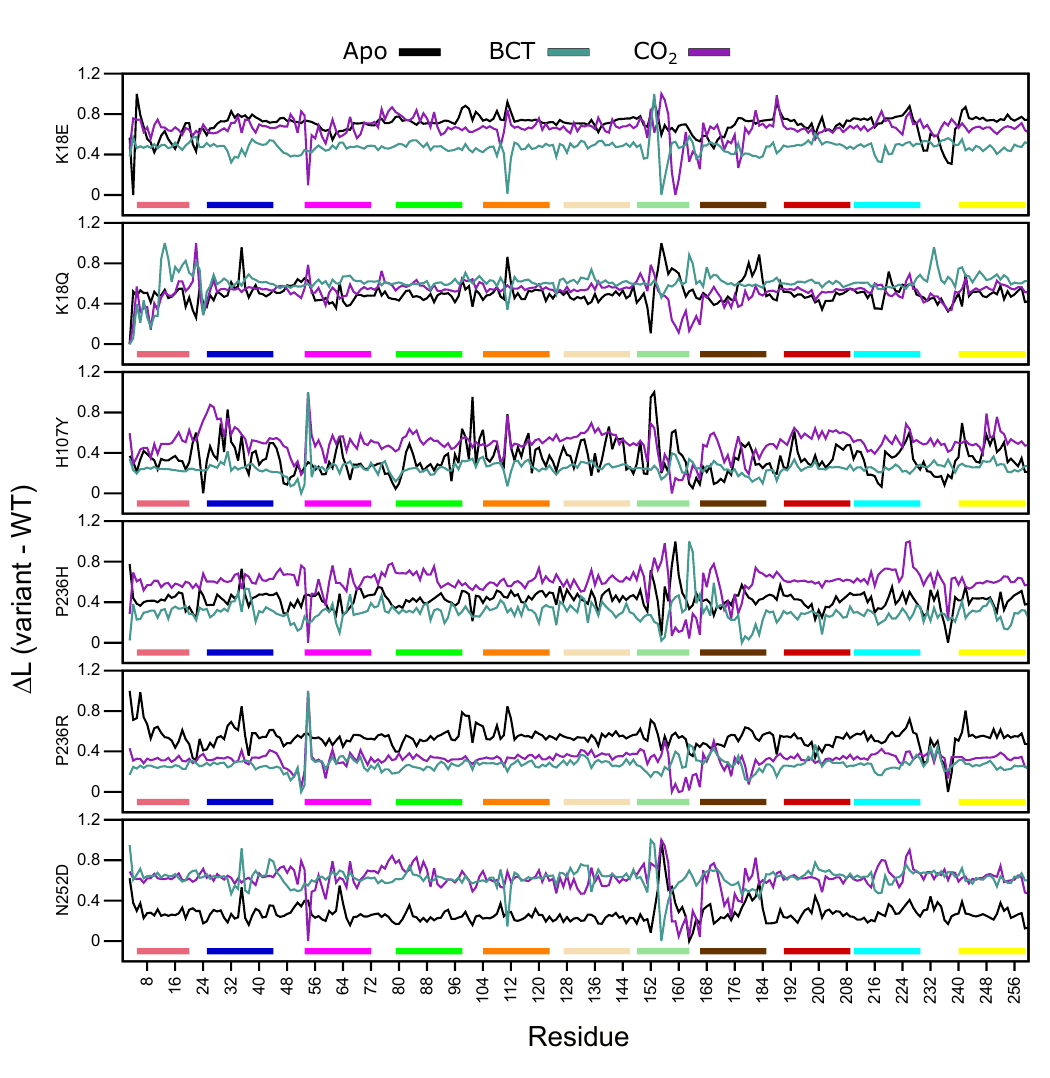
Figure 8. Change in average shortest path L between the WT and variant protein (variant minus WT) over the MD simulation. Respective motifs are indicated as bars at the bottom of each plot. Motif colors correspond to those in Figure